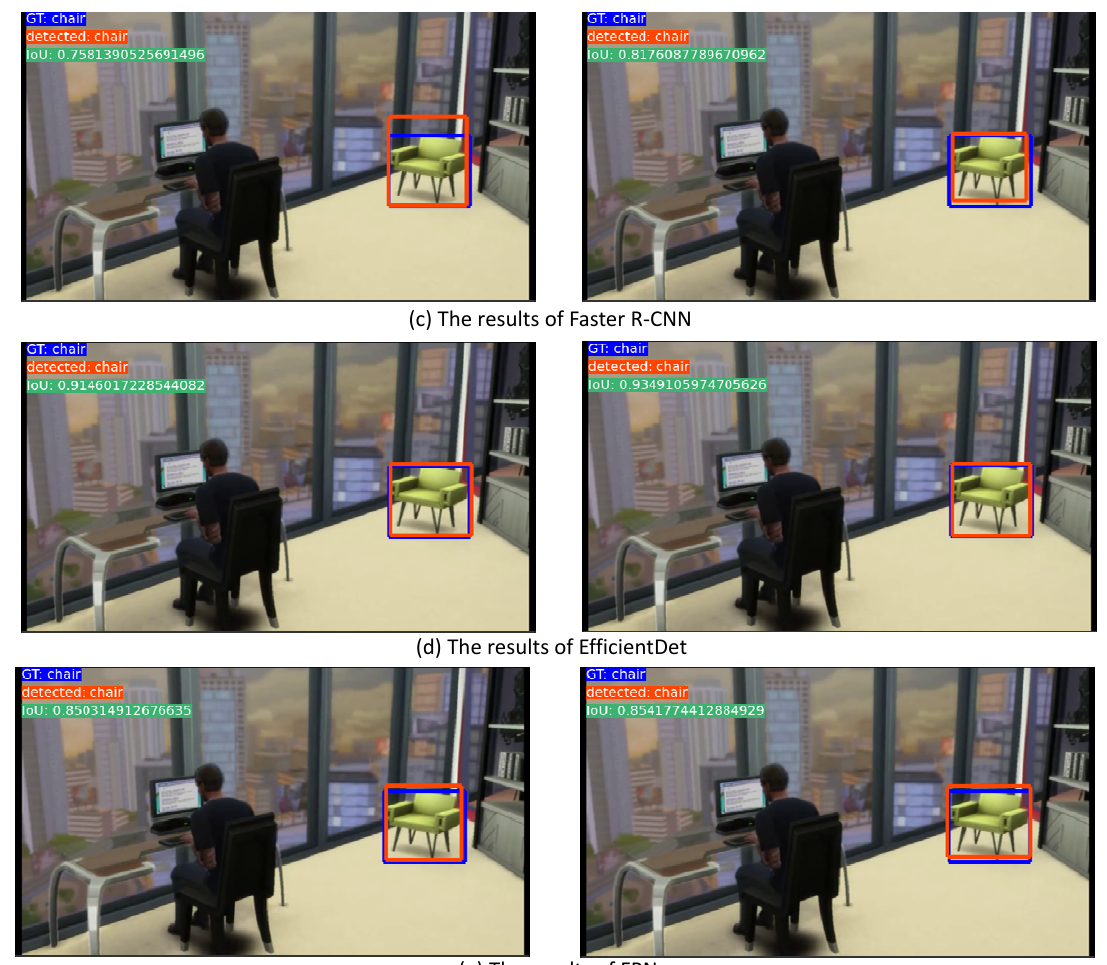
Figure A2. Comparison of the bounding box detection on game Sims . The left column is the result from the models trained by PASCAL VOC and the right column is the result from the models trained by PASCAL VOC and game